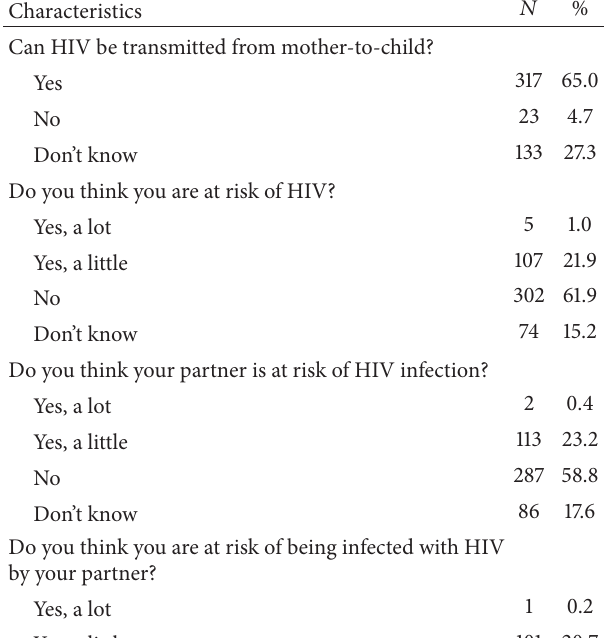
Table 1: HIV awareness, risk perception, testing history and family planning among pregnant women, Tbilisi, Georgia, 2009-2010, ANRS 12127